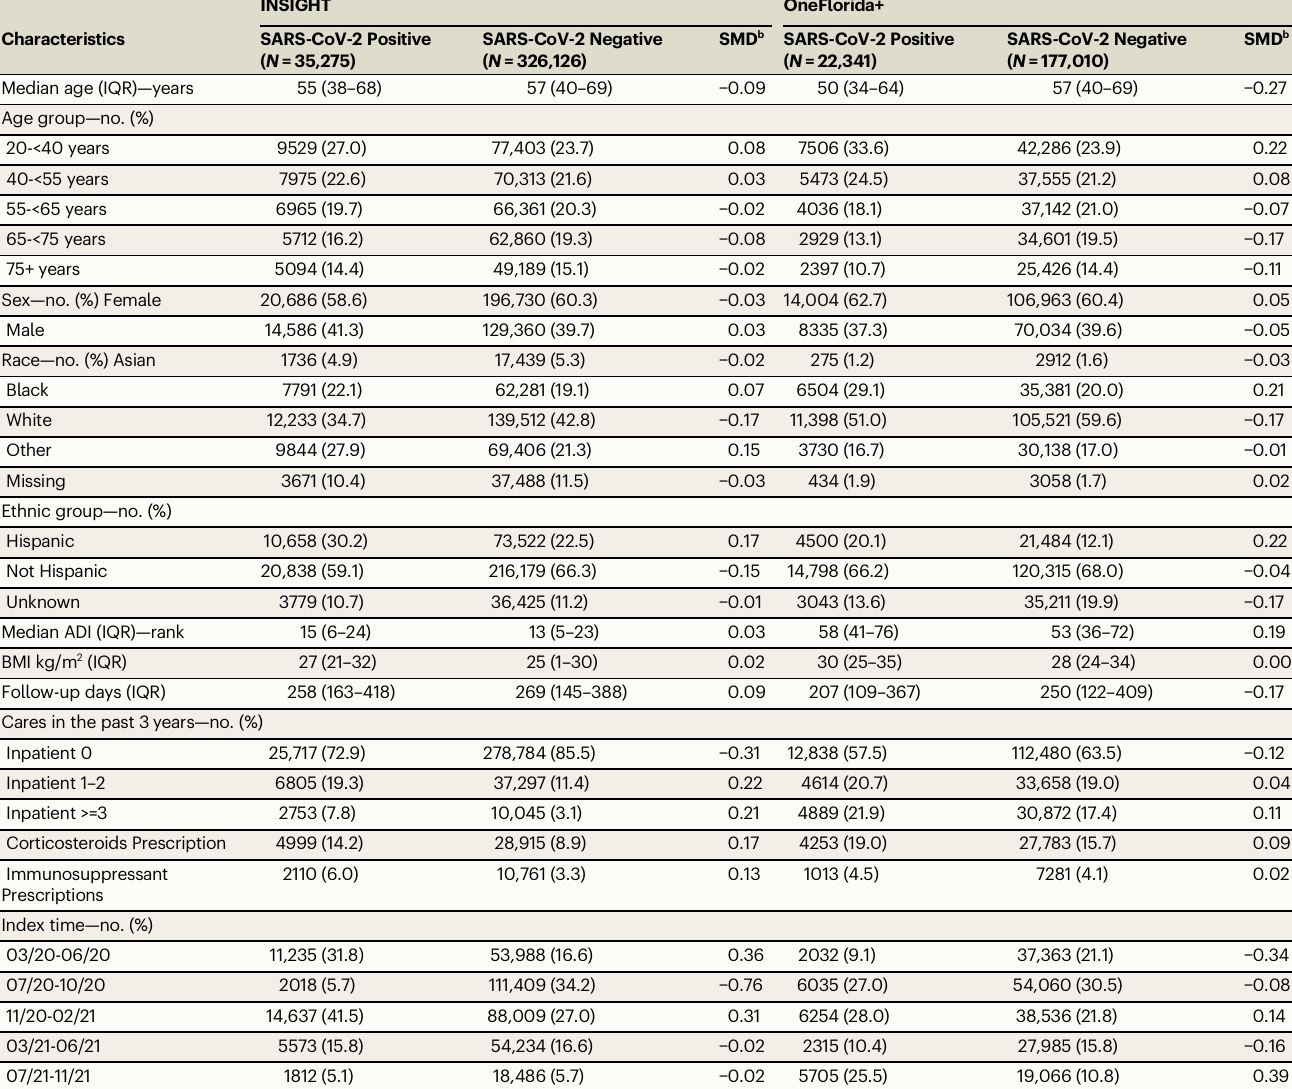
Table 1 | Baseline characteristics of the lab-con fi rmed SARS-CoV-2 positive patients and SARS-CoV-2 negative patients in